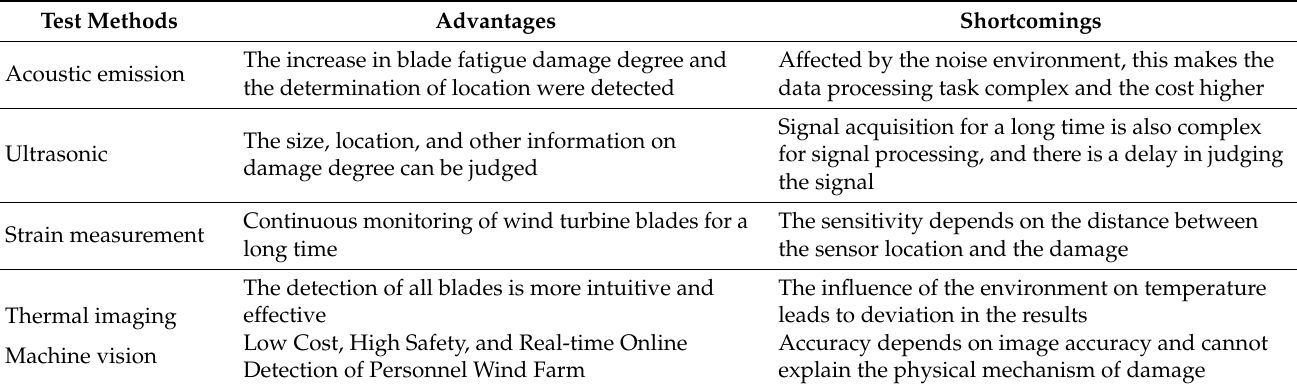
Table 1. List of the advantages and disadvantages of different detection methods